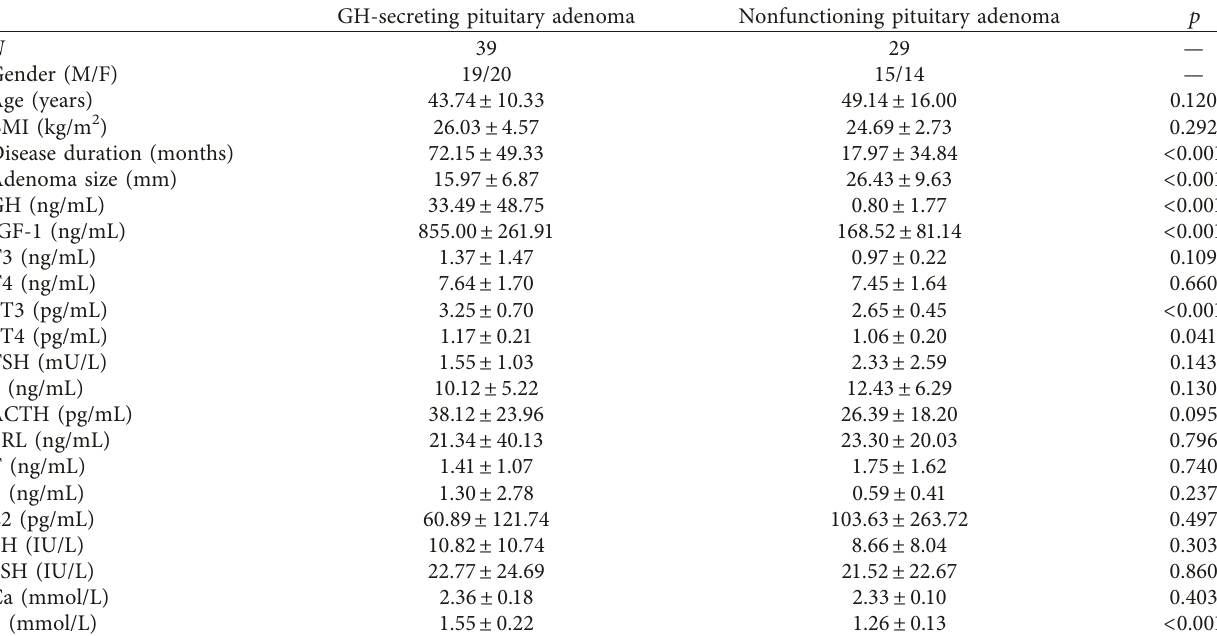
Table 1: Basic information of the GH-secreting pituitary adenoma group and the nonfunctioning pituitary adenoma group. GH-secreting pituitary adenoma Nonfunctioning pituitary adenoma